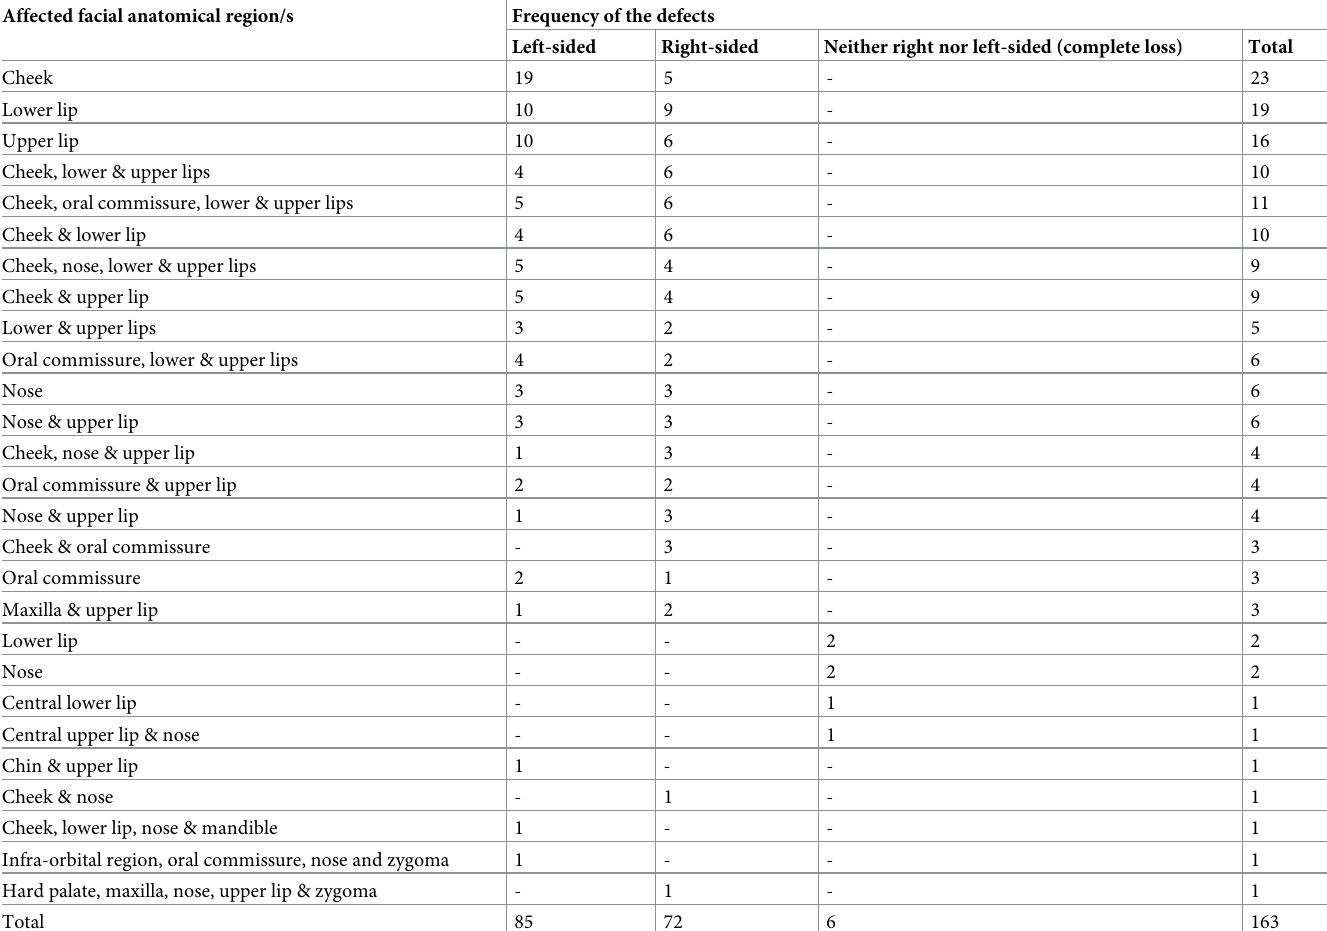
Table 1. Noma induced facial tissue damages and frequency of the